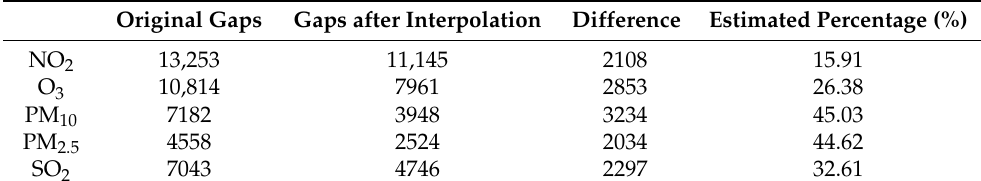
Table 2. Number of missing values (gaps) during 2018, for the original and spatially interpolated dataset. Original Gaps Gaps after Interpolation